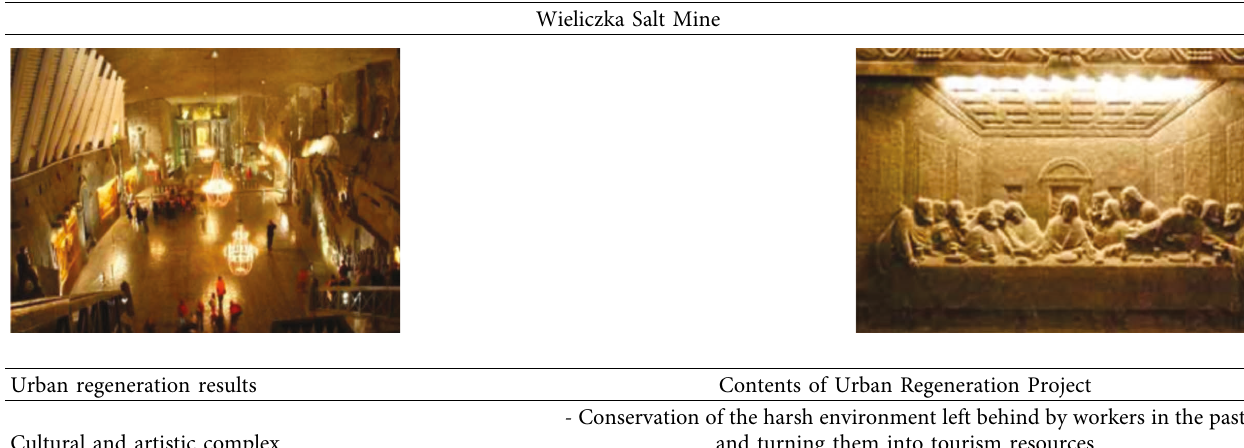
Table 6: Result of urban regeneration in Wieliczka Salt Mine, Poland.